Question: Identify the chart type used in this figure.
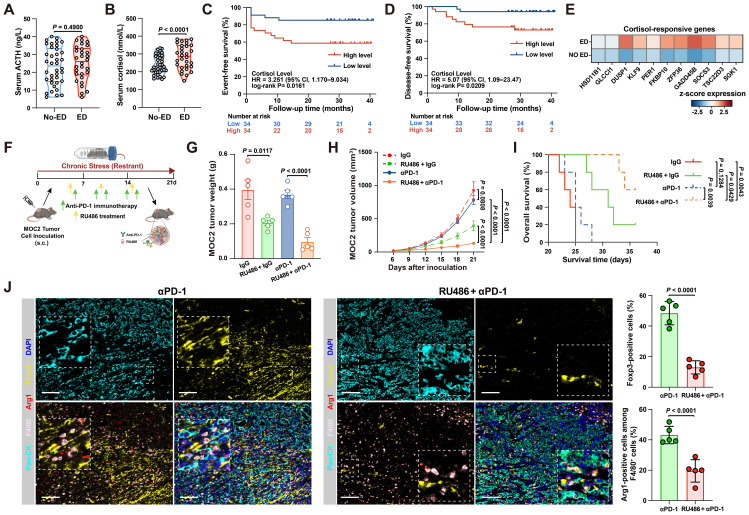
Answer: survival